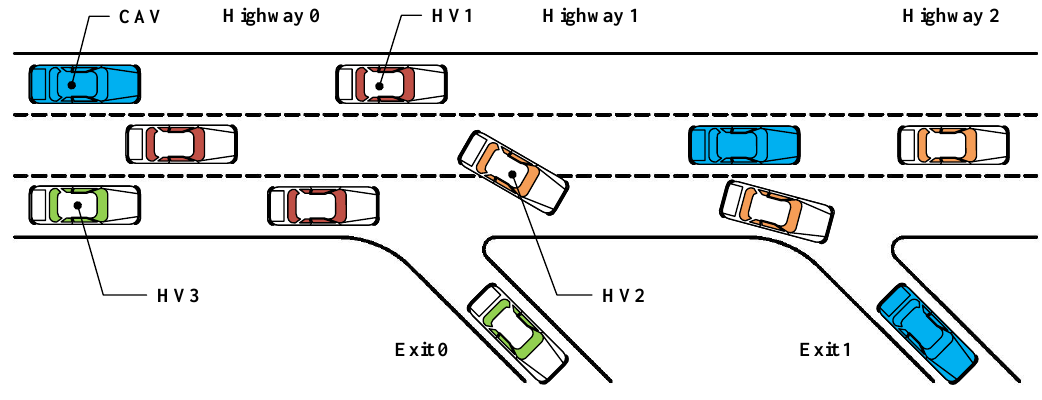
Figure 2. The highway exit scene with solid interactions between CAVs and